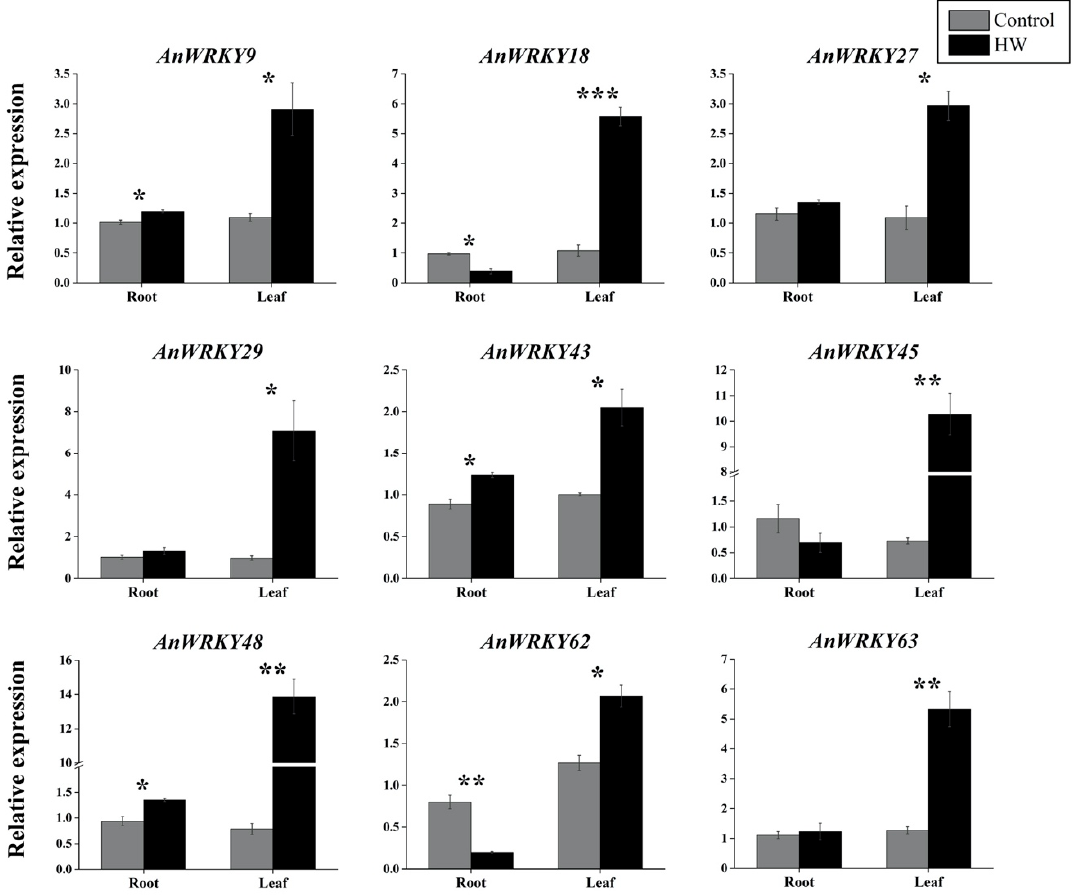
Figure 4. qRT-PCR assays of the expression of AnWRKY9 , 18 , 27 , 29 , 43 , 45 , 48 , 62 , and 63 in response to herbivory in roots and leaves. Black columns represent data for the one-day herbivory treatment, and gray columns represent the control data. HW: herbivory wounding. AnACTIN2 was used as an internal control. The mean and SE were derived from three biological and three technical replicates.